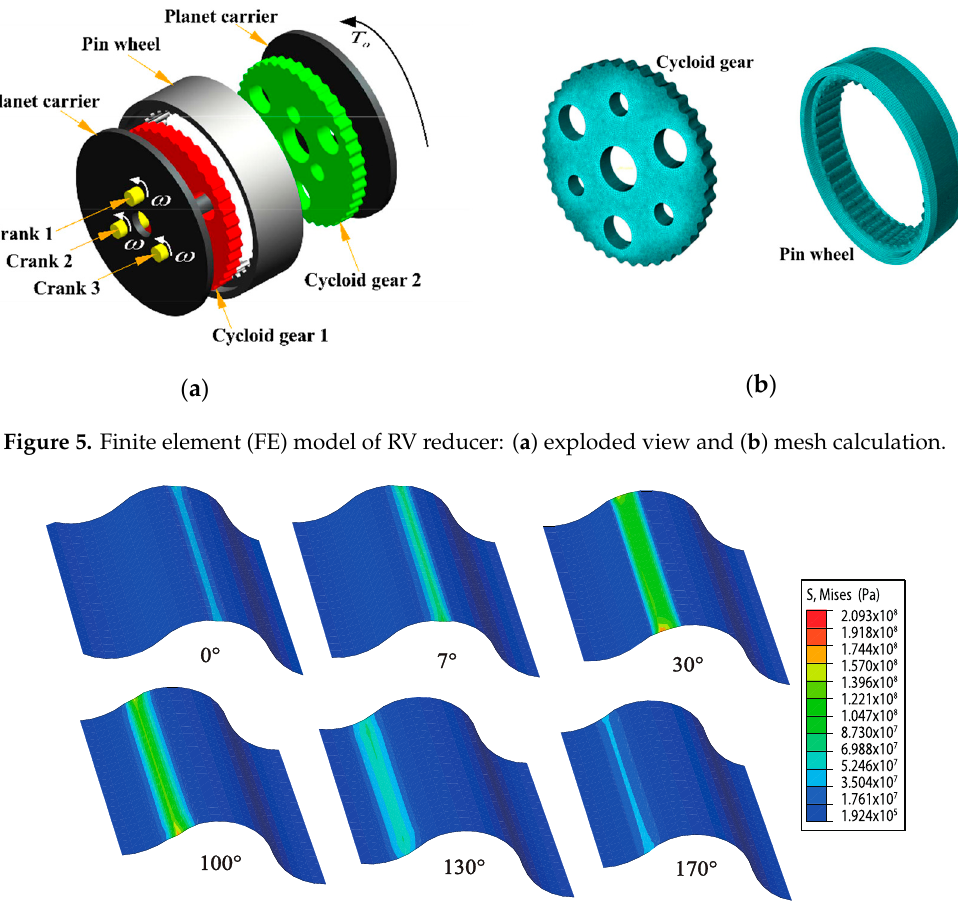
Figure 6. Contact stress on the cycloid tooth surface during meshing.